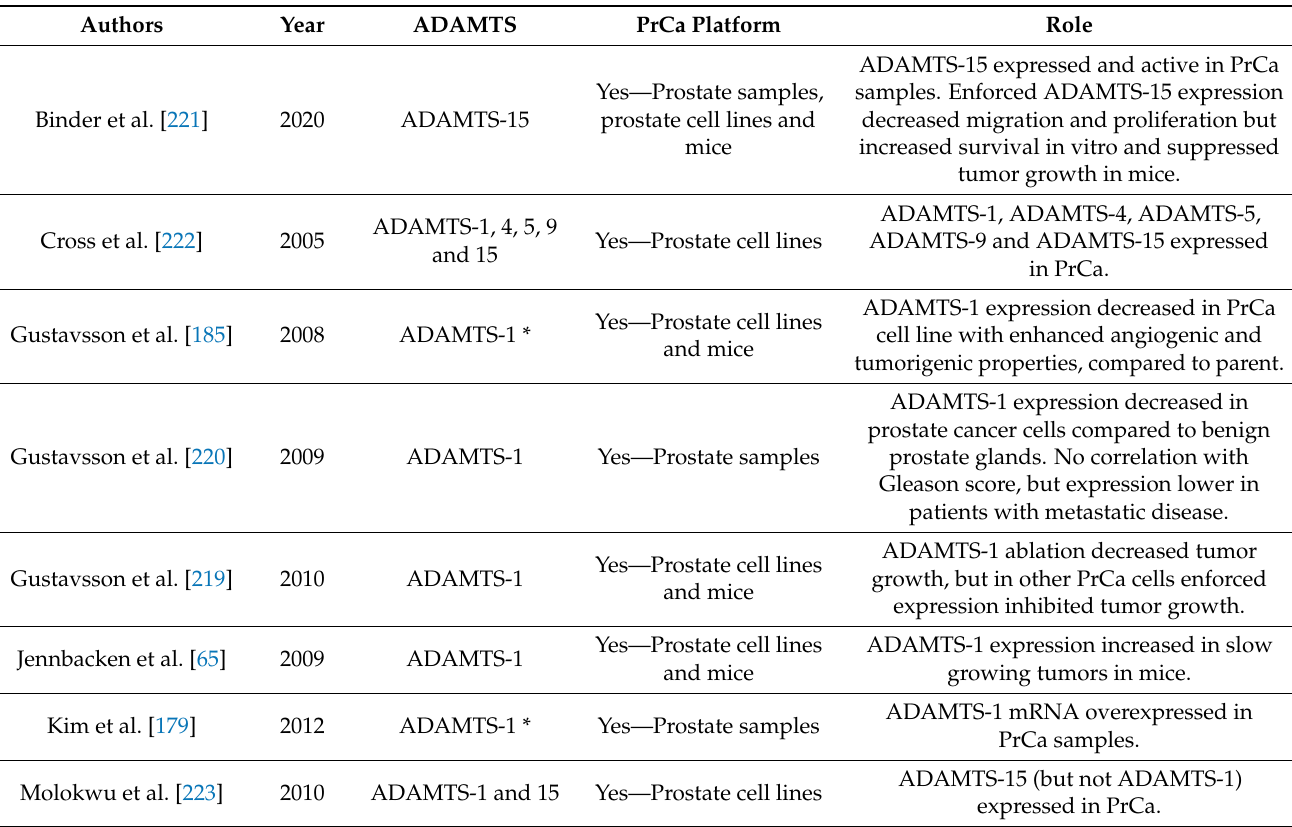
Table 5. Studies on A Disintegrin and Metalloproteinase with Thrombospondin Motifs (ADAMTSs) in PrCa.